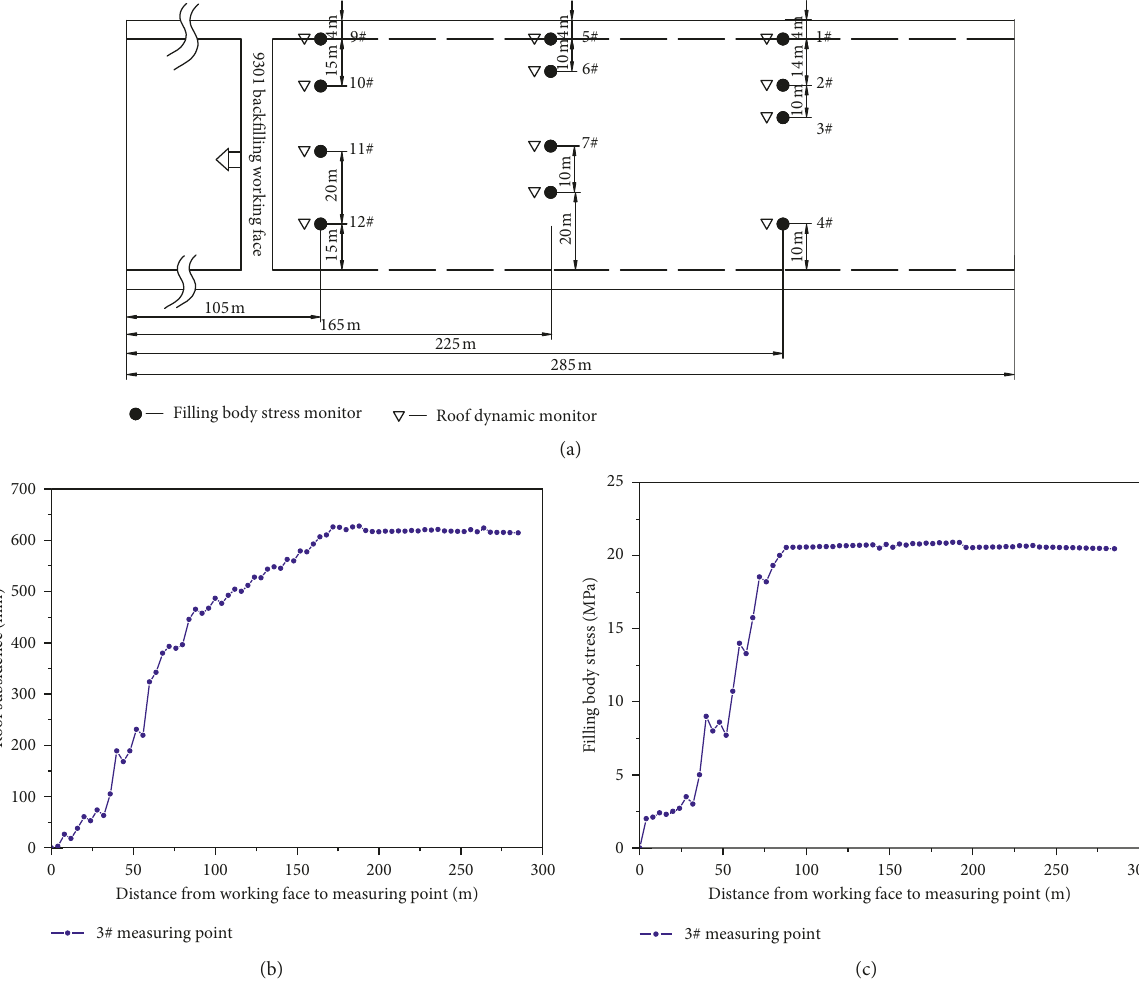
Figure 12: Roof dynamic subsidence measurement. (a) Actual measurement plan. (b) Roof subsidence curve. (c) Stress-strain of filling material.